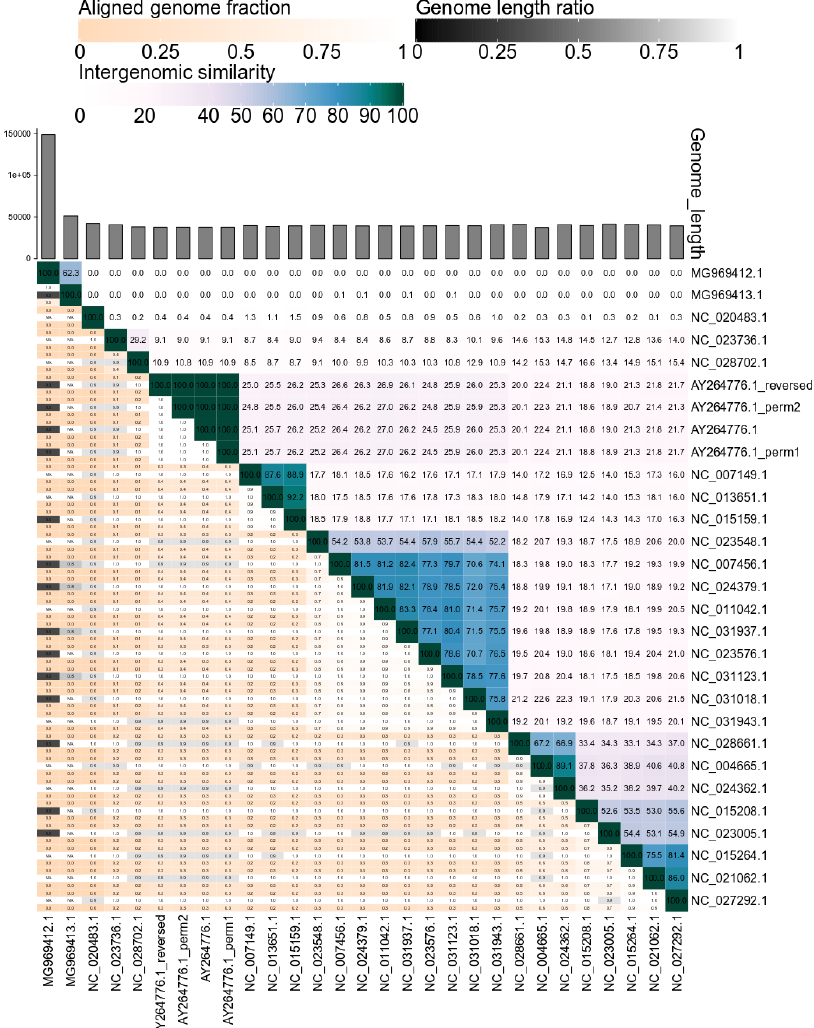
Figure 4. VIRIDIC generated heatmap incorporating intergenomic similarity values (right half) and alignment indicators (left half and top annotation). In the right half, the color-coding allows a rapid visualization of the clustering of the phage genomes based on intergenomic similarity: the more closely-related the genomes, the darker the color. The numbers represent the similarity values for each genome pair, rounded to the first decimal. In the left half, three indicator values are represented for each genome pair, in the order from top to bottom: aligned fraction genome 1 (for the genome found in this row), genome length ratio (for the two genomes in this pair) and aligned fraction genome 2 (for the genome found in this column). The darker colors emphasize low values, indicating genome pairs where only a small fraction of the genome was aligned (orange to white color gradient), or where there is a high di ff erence in the length of the two genomes (black to white color gradient). The aligned genome fractions are expected to decrease with increasing the distance between the phages. Therefore, darker colors should correspond to genome pairs with low similarity values, and whiter colors to genome pairs with higher similarity values. Similarly, more closely-related viruses are expected to have similar lengths. Therefore, if low genome length ratios correspond to genome pairs with high similarity (e.g., MG969412.1 and MG969413.1 have a 62.4% similarity, but only 0.3 genome length fraction), this signals that the pair needs to be investigated further before being classified. The genome of the K155 strain of the T7 phage (AY264776.1) and its permuted (AY264776.1_perm1 and AY264776.1_perm2) and reversed complemented (AY264776_reversed) variants presented no significant di ff erences between their intergenomic similarity